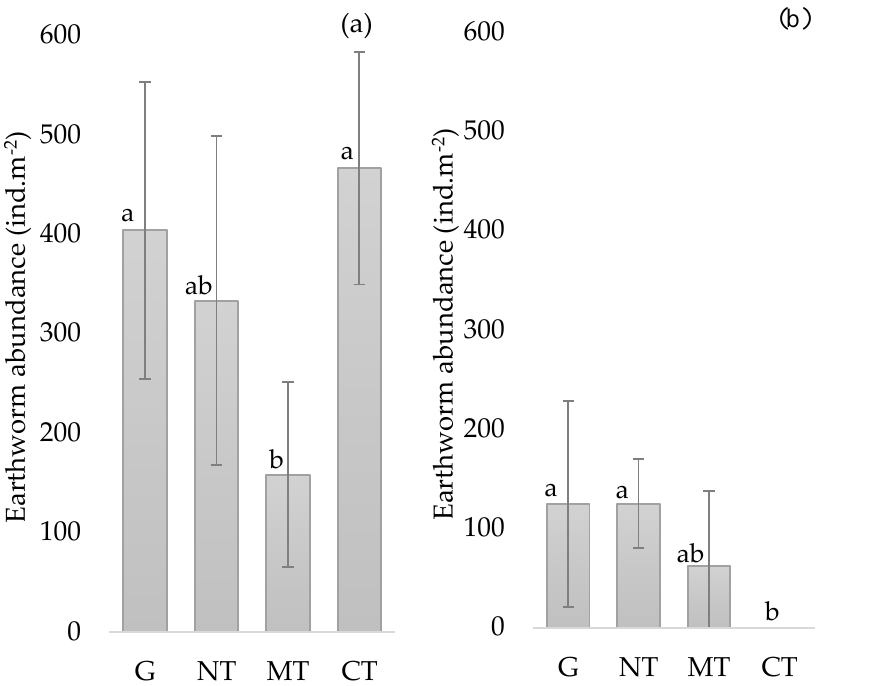
Figure 2. Earthworm abundance of studied management treatments in ( a ) 2016 and ( b ) 2018 (n = 6 per each year and management treatment). Letters indicate statistical differences between management types according to Tukey post hoc test ( p < 0.05) within each year. Codes for land management